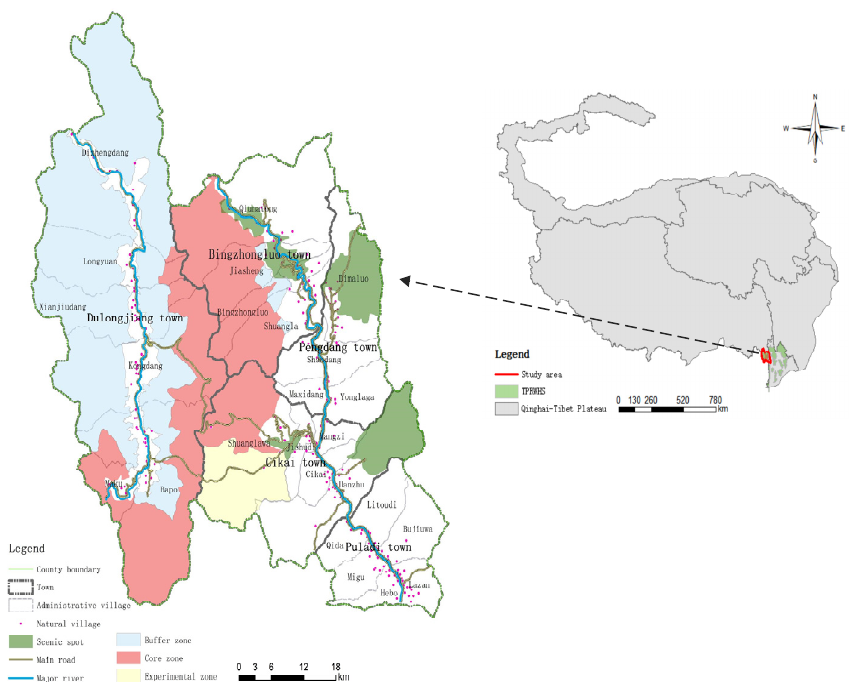
Figure 2. The location of the Gongshan area in the case study.